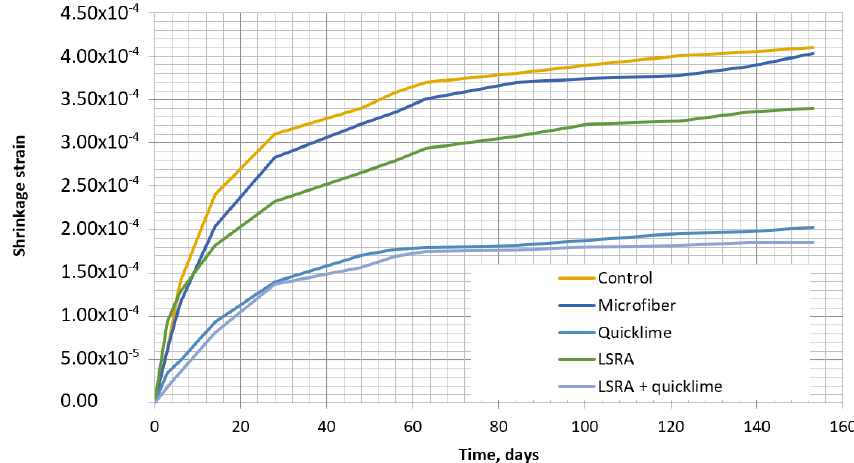
Figure 6. Dependences of shrinkage deformations of the various specimens on curing